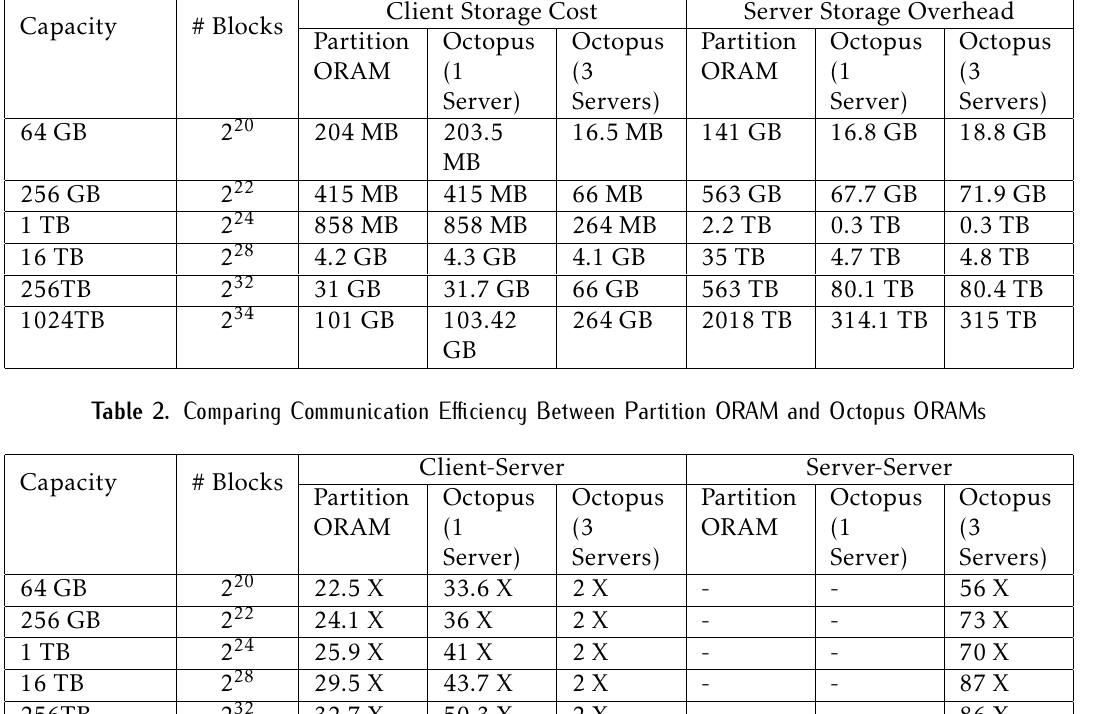
Table 1. Comparing Storage Efficiency Between Partition ORAM and Octopus ORAMs Capacity